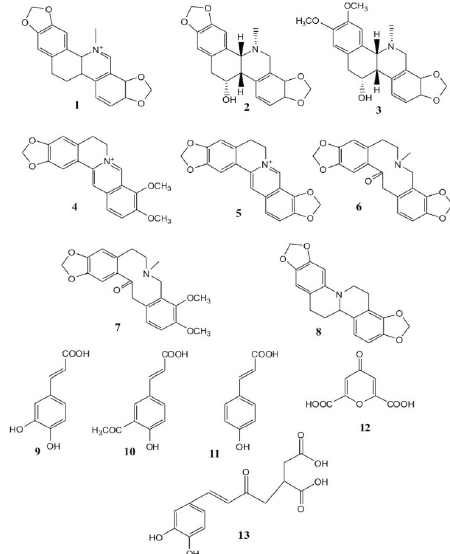
Figure 1. Medically valuable natural compounds of greater celandine: sanguinarine ( 1 ), chelidonine ( 2 ), chelerythrine ( 3 ), protoberberines, berberine ( 4 ), coptisine ( 5 ), protopine (6 ), allocryptopine ( 7 ), stylopine ( 8 ), caffeic acid ( 9 ), ferulic acid ( 10 ), p-coumaric acid ( 11 ), chelidonic acid ( 12 ), caffeoyl-malic acid ( 13 ).